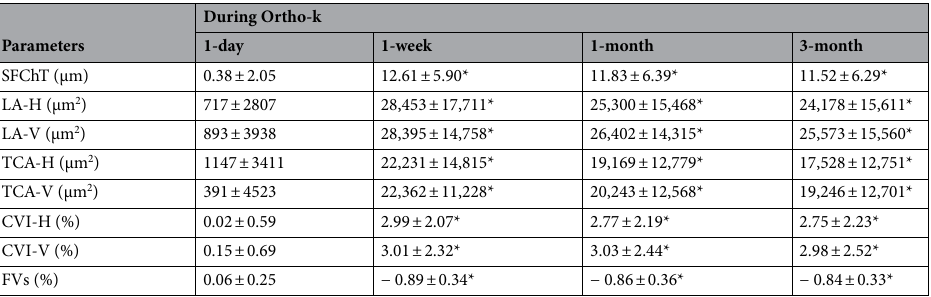
Table 3. Changes (mean ± SD) from baseline in choroidal parameters during 3 months of follow-up in the Ortho-K group. SFChT: sub-foveal choroidal thickness, LA-H: choroidal vascular luminal area on horizontal scan, LA-V: choroidal vascular luminal area on vertical scan, TCA-H: total choroidal area on horizontal scan, TCA-V: total choroidal area on vertical scan, CVI-H: choroidal vascularity index on horizontal scan, CVI-V: choroidal vascularity index on vertical scan, FVs: choriocapillaris flow voids. *P < 0.05 by repeated-measure ANOVA.